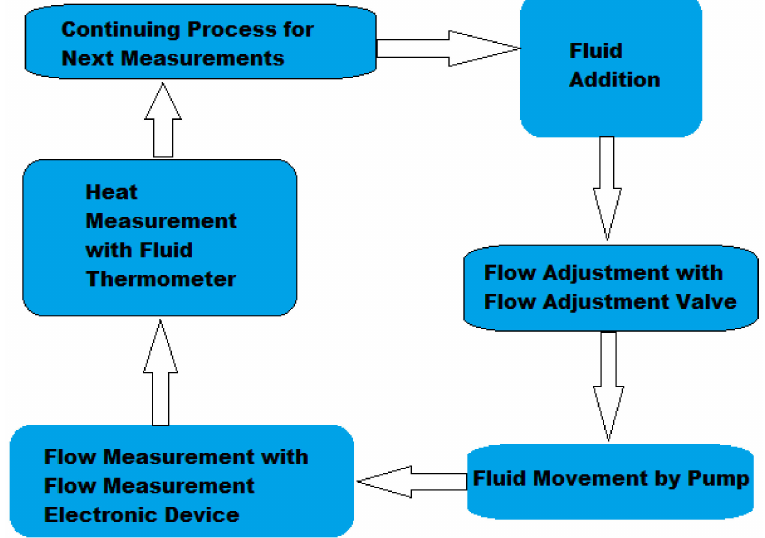
Figure 3. The diagram of measurements made in the experimental